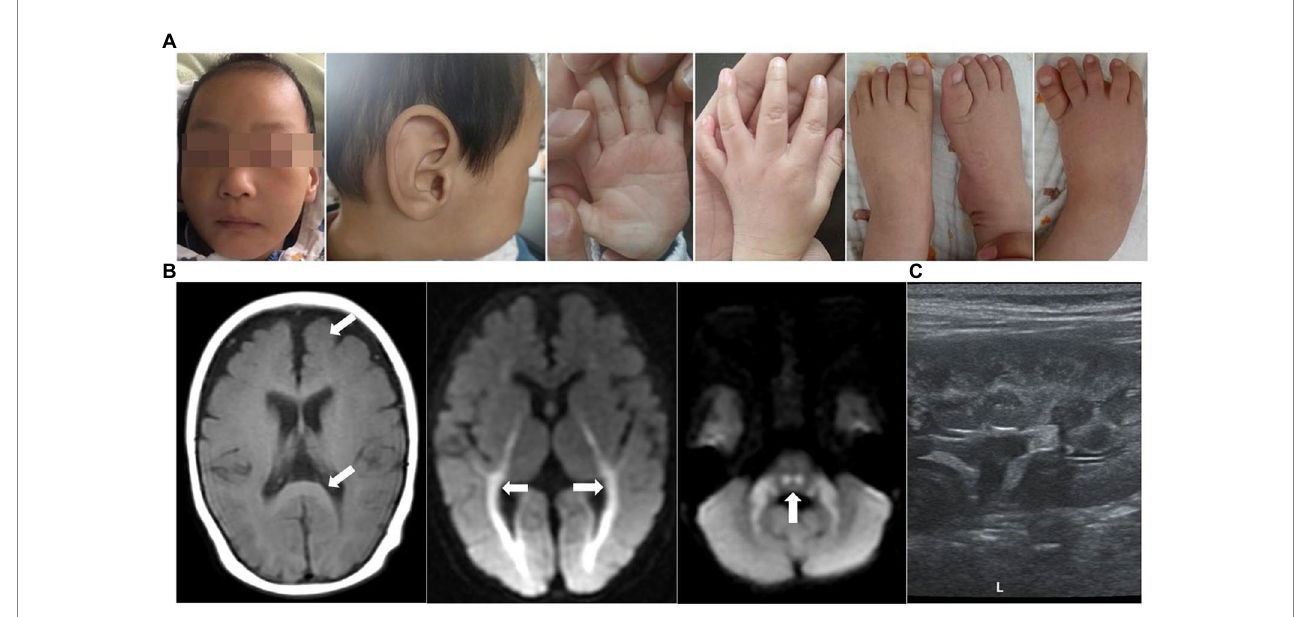
FIGURE 1 Clinical features of patient 1. (A) Images of faces, hands, and feet showed microcephaly, wide eye spacing, giant ear (large and soft external auricle), disordered palmar pattern, and conical fingers. (B) Brain MRIs performed at the age of 8 months: Axial T1-weighted and DWI images demonstrated an enlarged ventricular system, widened bilateral lateral fissure, anterior longitudinal fissure, and frontotemporal extracerebral space, as well as a slightly wider cerebral gyrus (white arrow). (C) Renal ultrasound disclosed enhanced renal